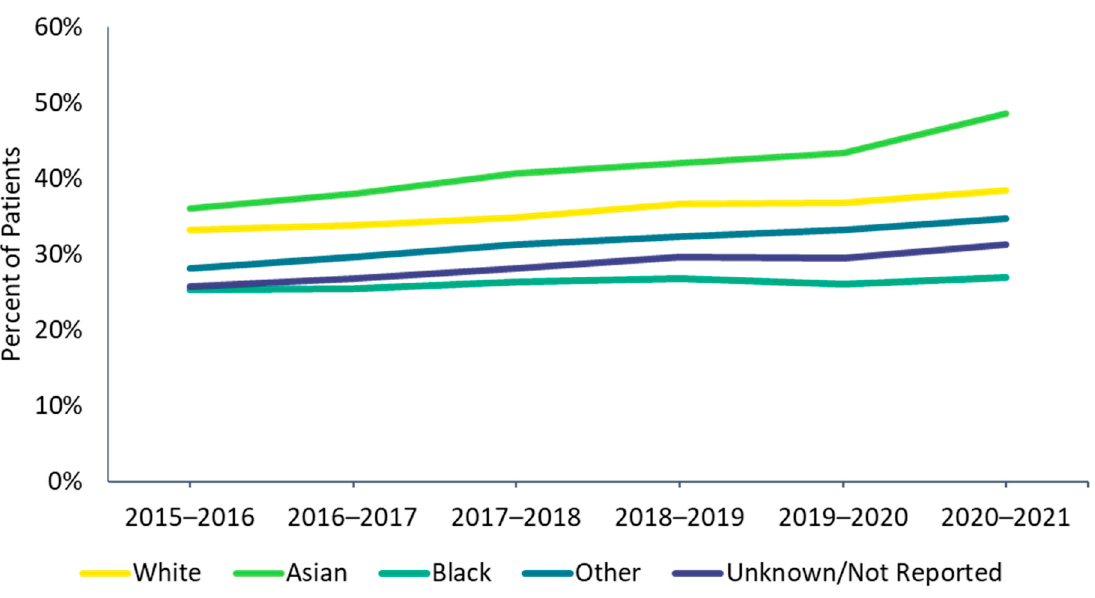
Figure 2. Influenza vaccine uptake by race, 2015–2016 through 2020–2021 influenza seasons.